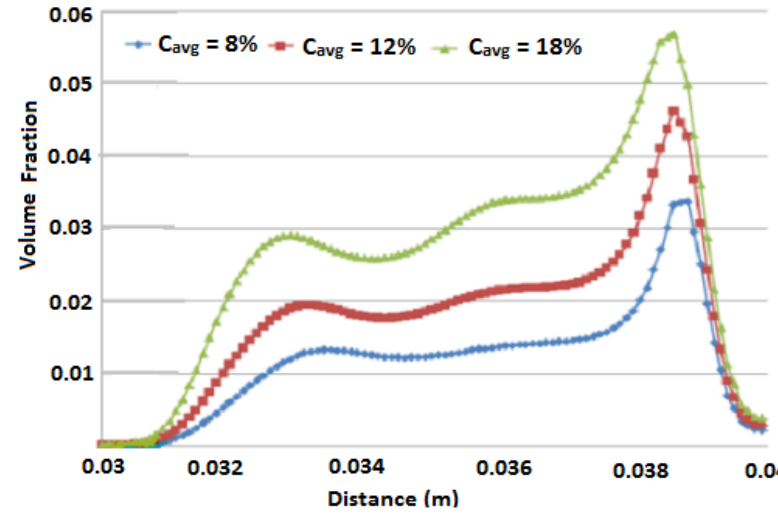
Figure 11. Comparison of solid phase volume fraction for different initial solid phase concentration in slurry sample W 3 for R OH = 0.02 (33 RPM) and constant V = 7.78 m/s along Plane 4